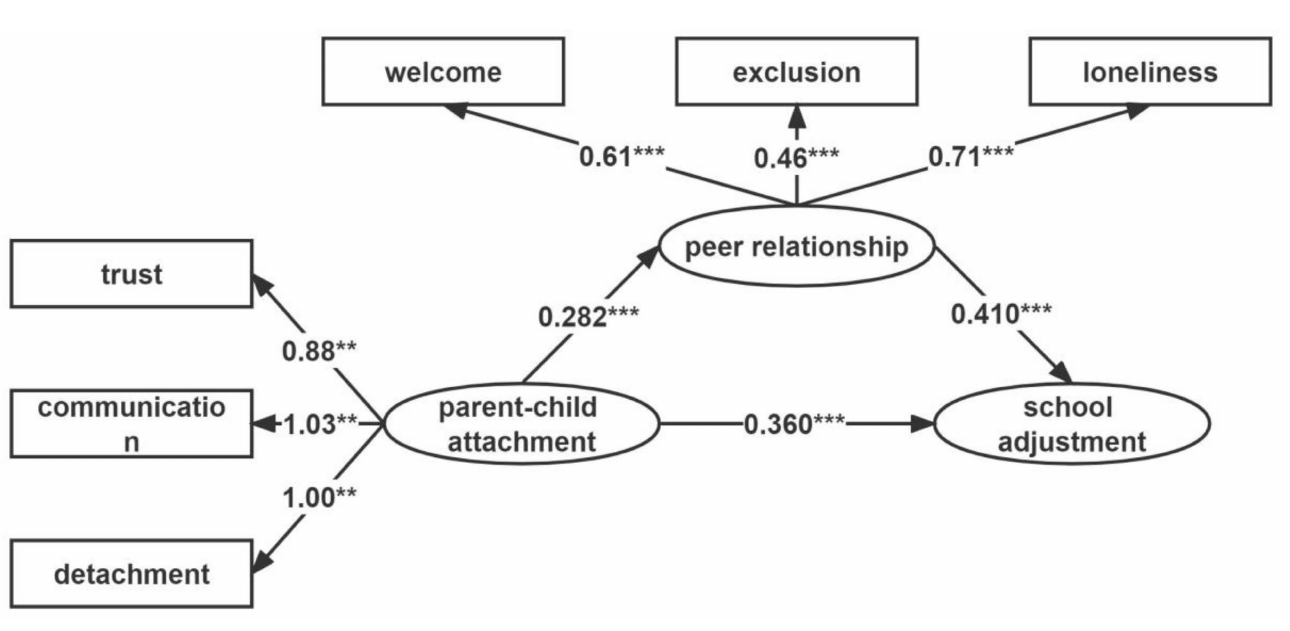
Figure 1. The model of peer relations mediating the relationship between parent–child attachment and school adjustment. ** p < 0.01, *** p < 0.001.